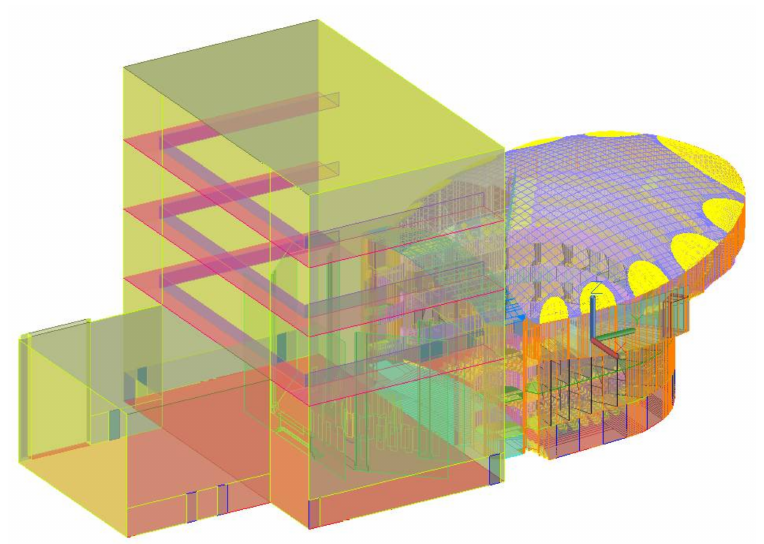
Figure 4. Digital model of the National Theater of Zagreb: axonometric view of the entire